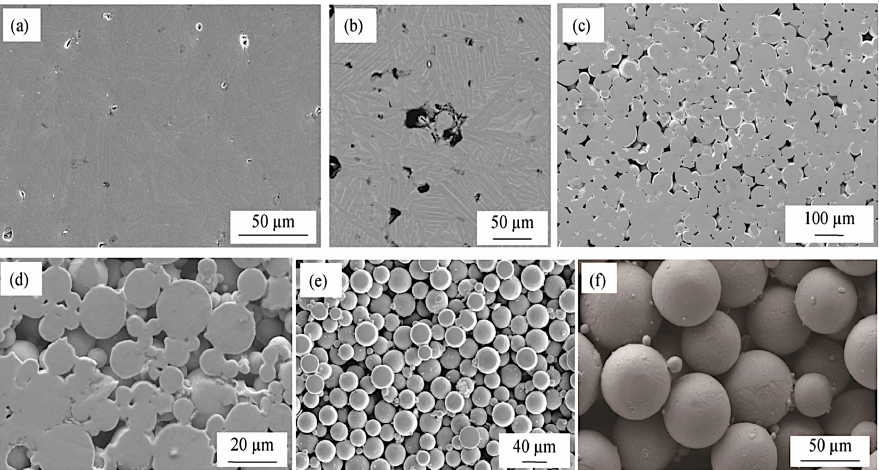
Figure 4. SEM micrographs of samples sintered at 1260 ◦ C with particle diameters of ( a ) 0–20µm, ( b ) 20–45µm, and ( c ) 45–75µm; sintered at 900 ◦ C for ( d ) 0–20µm, ( e ) 20–45µm, and ( f ) 45–75µm. Reprinted with permission from Springer Nature Customer Service Centre GmbH: Springer, Interna- tional Journal of Minerals, Metallurgy, and Materials